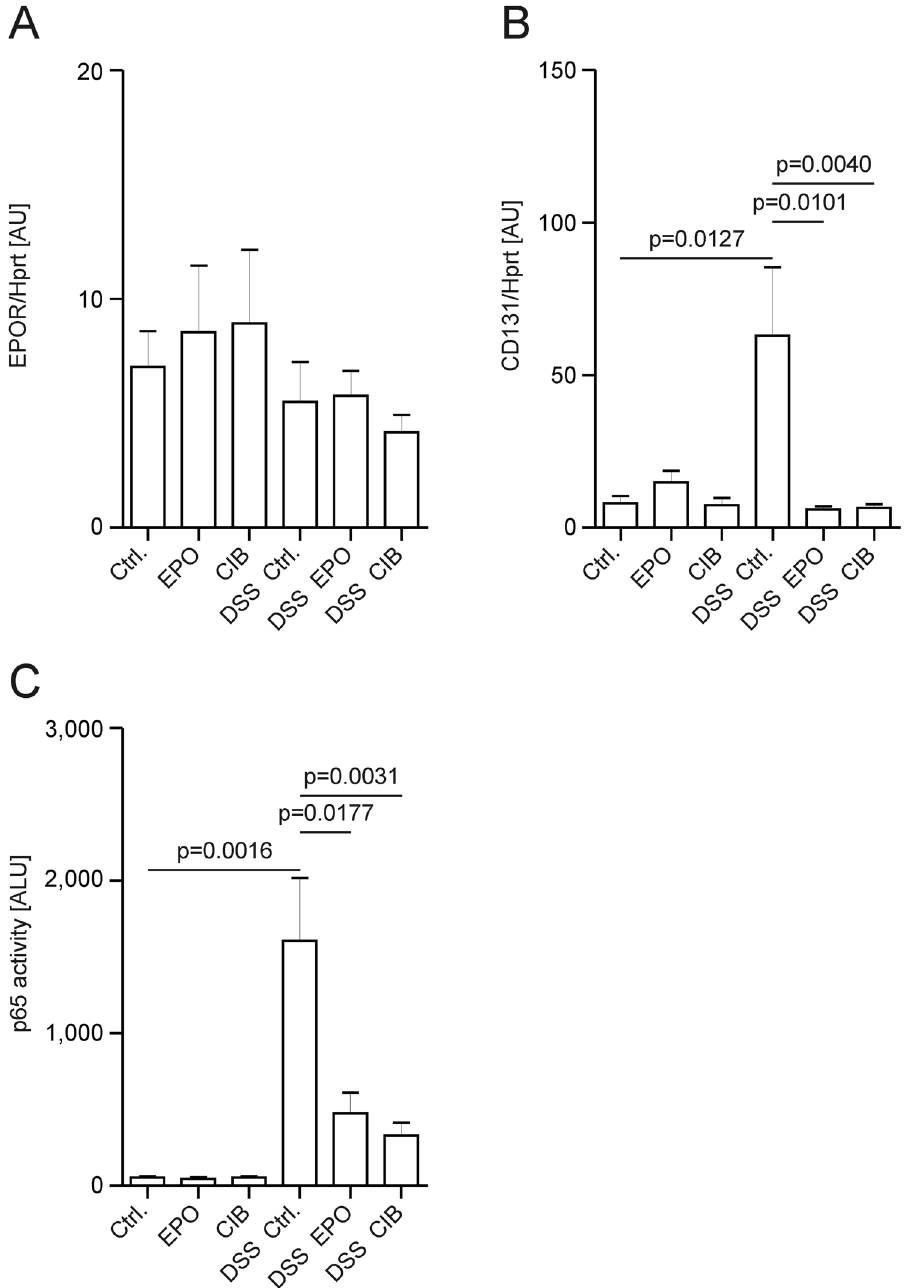
Figure 3. EPO and cibinetide counteract NF- κ B p65 activation in lamina propria macrophages. CD11b + CD11c − macrophages were FAC-sorted from the colonic lamina propria on d14 of DSS exposure to prepare total RNA and nuclear proteins. Epor ( A ) and CD131 ( B ) mRNA expression was assessed by qPCR. Activation of p65 ( C ) was measured by an ELISA-based assay. Data were compared by Kruskal-Wallis testing. n = 5–12 mice per